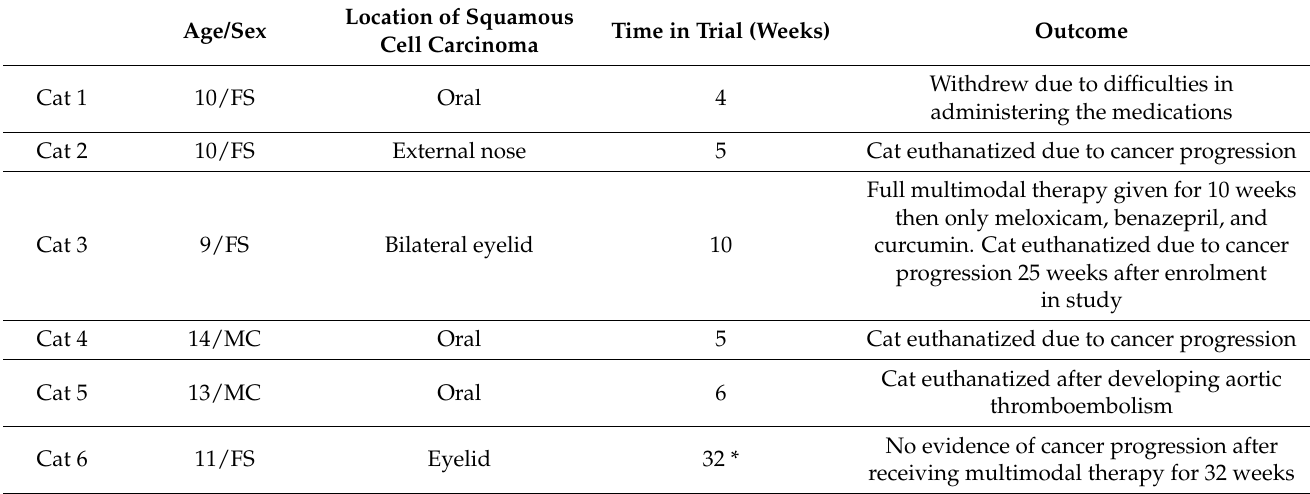
Table 3. Summary of the clinical information and clinical outcome of cats receiving a multimodal blockade of the renin-angiotensin system. * indicates that, at the time of writing, the cat is still alive and receiving multimodal treatment. FS indicates a female spayed cat; MC indicates a male castrated